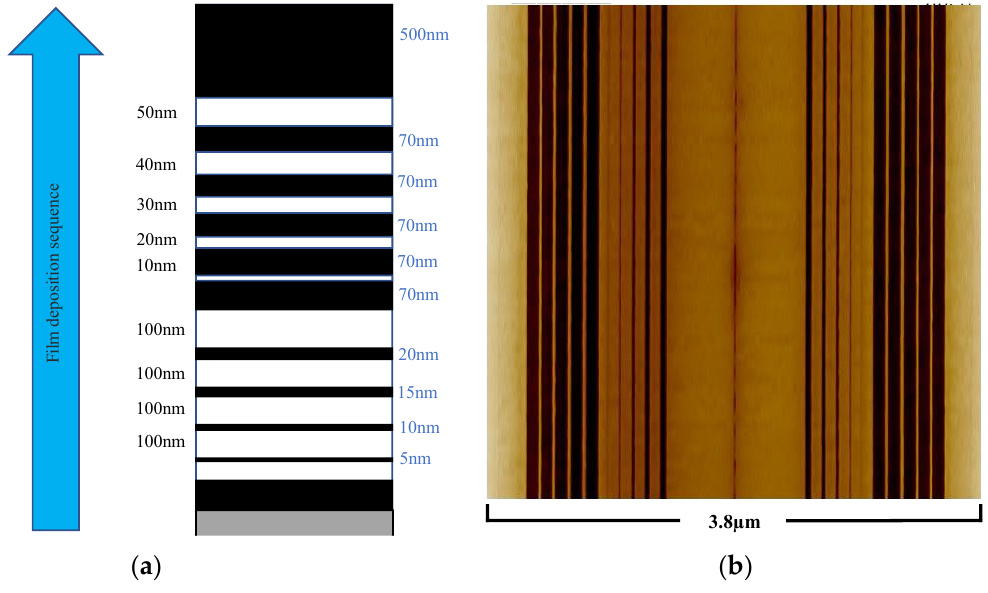
Figure 2. Multi-structured tip characterizer:( a ) film layer design; ( b ) AFM image.